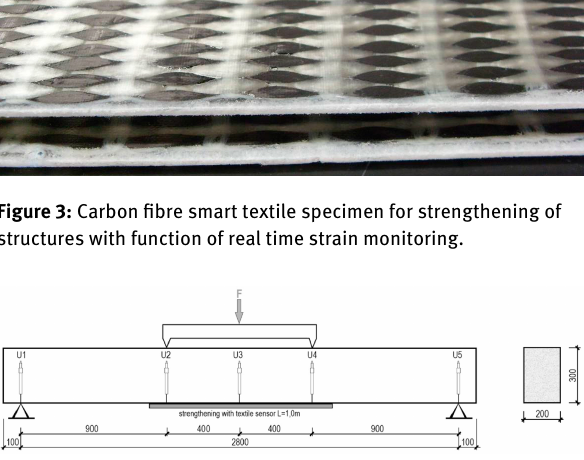
Figure 4: Scheme of the test on reinforced concrete beam with tex- tile sensor.